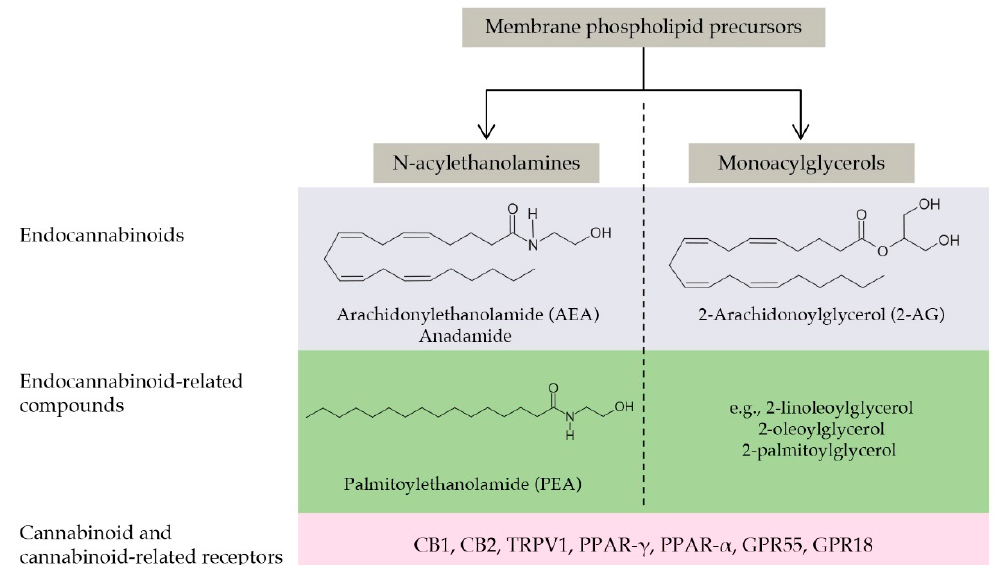
Figure 5. The main components of the endocannabinoidome: a schematic view. The endocannabinoidome comprises several lipid ligands classified according to their chemical structures in N-acylethanolamines and monoacylglycerols. Ligands are further subgrouped as endocannabinoids (i.e., agonists at CB1 and CB2 cannabinoid receptors) and endocannabinoid congeners being inactive at cannabinoid receptors. The arachidonic acid derivatives AEA and 2-AG belong to the first group, while PEA to the second one (together with several similar compounds not discussed in the present review). The endocannabinoidome also comprises the biosynthetic and degradative enzymes of these ligands (here not shown for the sake of simplicity) and the cannabinoid (i.e., CB1 and CB2) and cannabinoid-related receptors, such as those of the PPAR or GPR families. The reader is referred to Cristino et al., 2020 [174] for a more comprehensive review of this topic.